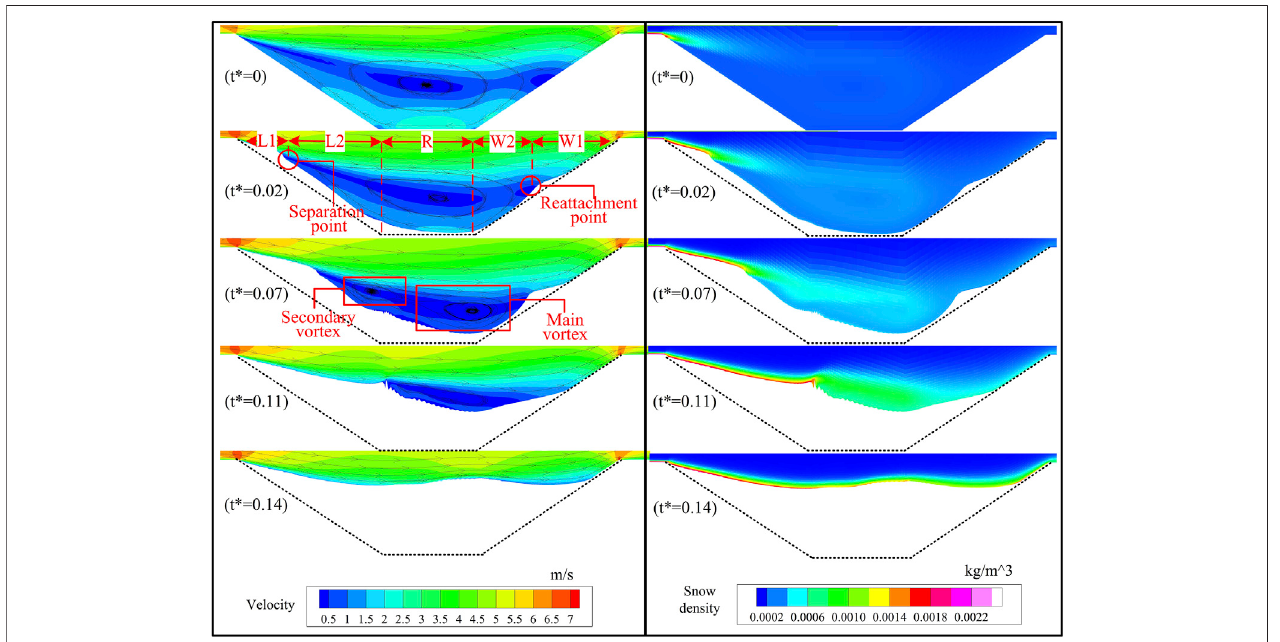
FIGURE 8 | Flow fi eld and snow density around the road cutting at different times. Cutting fl ow fi elds and wind streamlines around the cutting at representative timesare shown in Figure 7 . The vortex separation point and reattachment point are marked in the fi gure, which divides the road cutting into fi ve areas. In Figure 7 , the position of the secondary vortex is also specially marked. Its appearance divides the road cutting wind blowing snow disaster into three stages. The variation of two points and vortex scale in each stage is described.